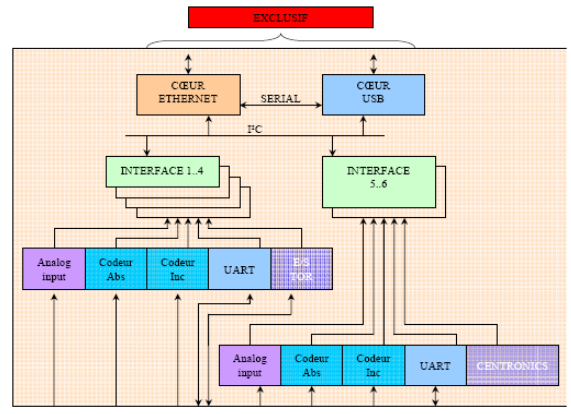
Fig. 4. Electronic shema architecture. General organization and interfaces between the different